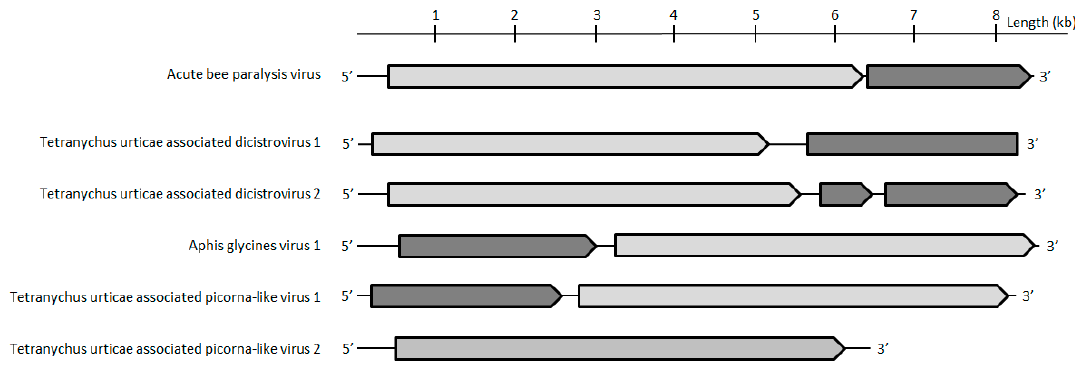
Figure 5. Maximum Picornavirales likelihood phylogenetic tree based on part of the polymerase protein, including 504 sequences and Tetranychus urticae-associated picornaviruses (in bold). The alignment of 386 amino acids in length was produced using MUSCLE 3.7 (16 iterations) and was ungapped by hand. The tree was mid-point rooted. Bootstrap values are indicated at each node, values <50% were discarded to not overload the tree. Scale bar corresponds to amino acid substitutions per site. Families of the Picornavirales order and genera of the Dicistroviridae family are indicated in brackets. Genomic organization of Tetranychus urticae-associated picornaviruses is also indicated. Grey arrows and rectangles: predicted open reading frames (ORF), Light grey: putative NS; dark grey: putative CP. Arrows: complete ORF.